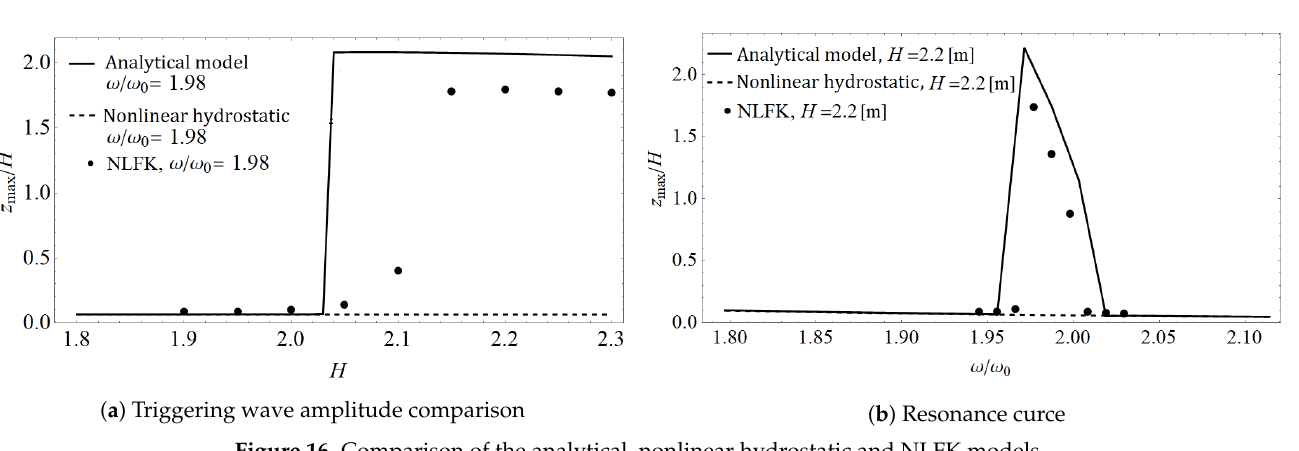
Figure 16. Comparison of the analytical, nonlinear hydrostatic and NLFK